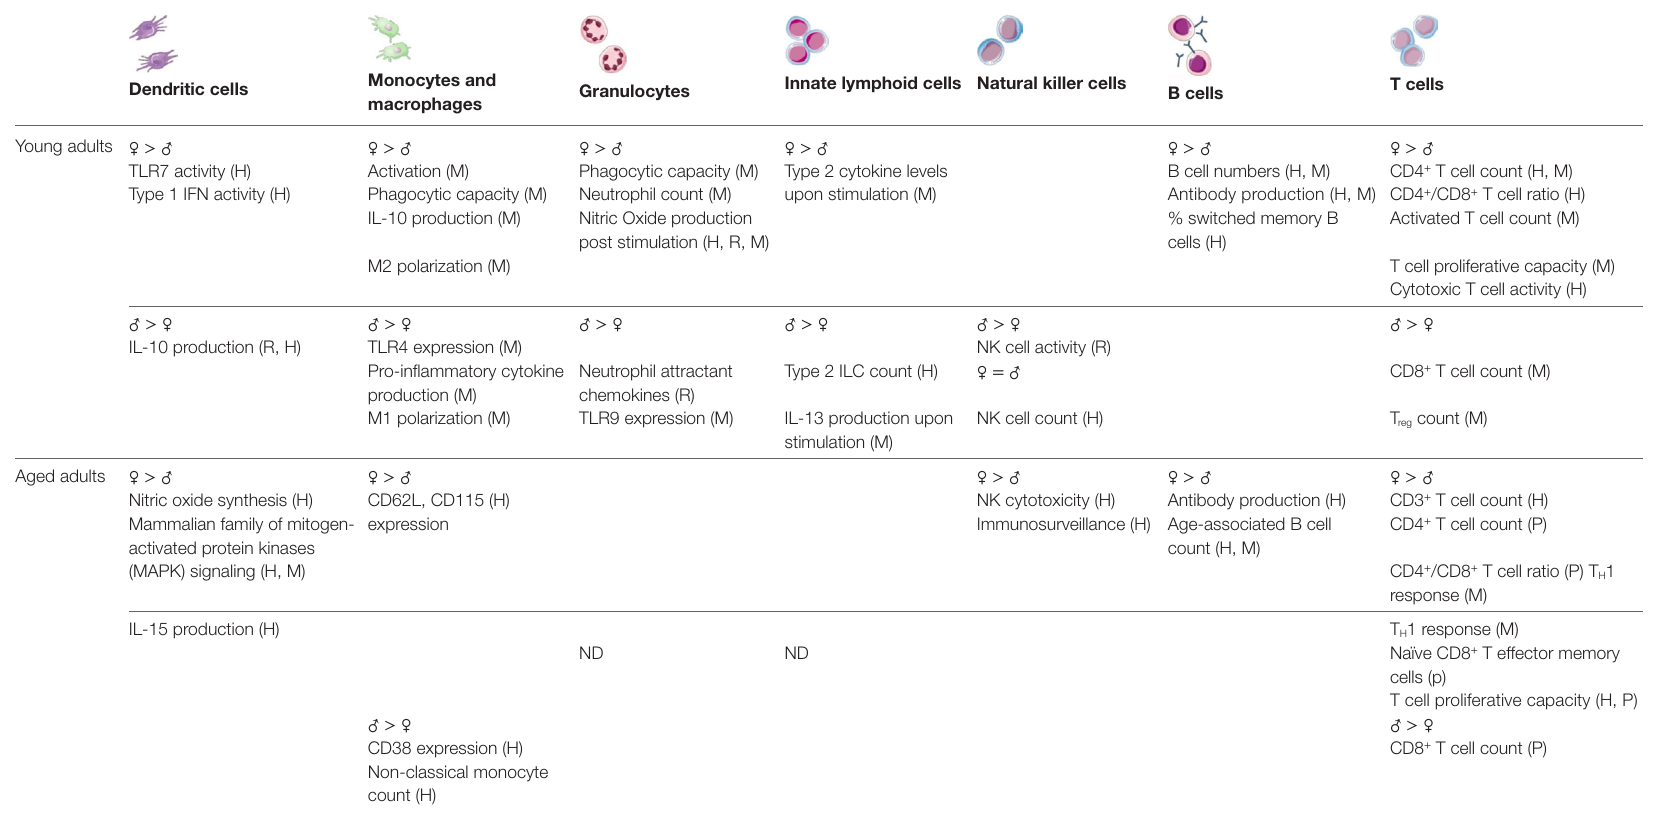
TABLe 1 | Sex differences in innate and adaptive immune responses in young and aged